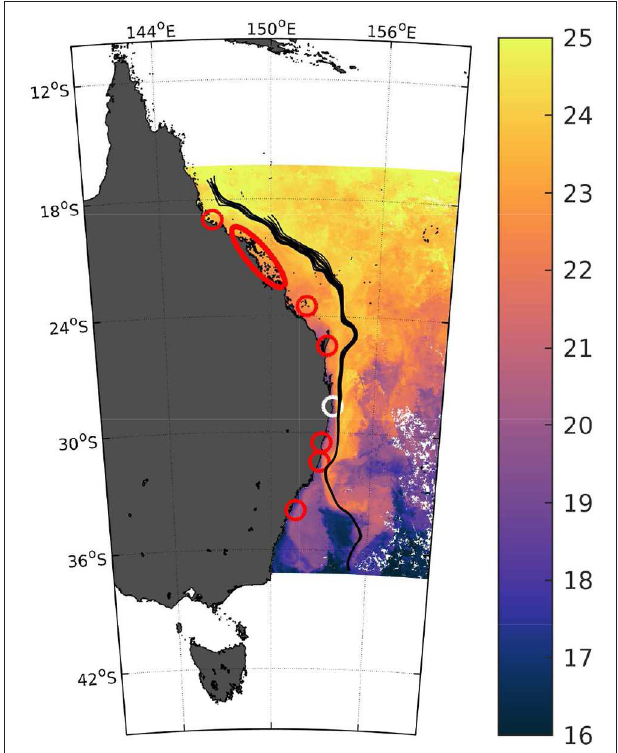
FIGURE 1 | Upwelling along the east Australian shelf. Sea surface temperatures in degrees Celsius (6 day composite) on August 18 th 2017 off the East Australian coast. While the white circle marks the study location, red circles and ellipse denote areas with documented upwelling events (north to south) reported in Andrews and Furnas (1986), Oke and Middleton (2000), Roughan and Middleton (2002), Berkelmans et al. (2010), Malcolm et al. (2011) , Schaeffer et al. (2013), Mao and Luick (2014), Tran et al. (2015), Wijffels et al. (2018), and Gibbs et al. (1998). The black lines highlight the continuous southwards flow of the East Australian Current in the week around August 22 nd 2017 ( Bonjean and Lagerloef,